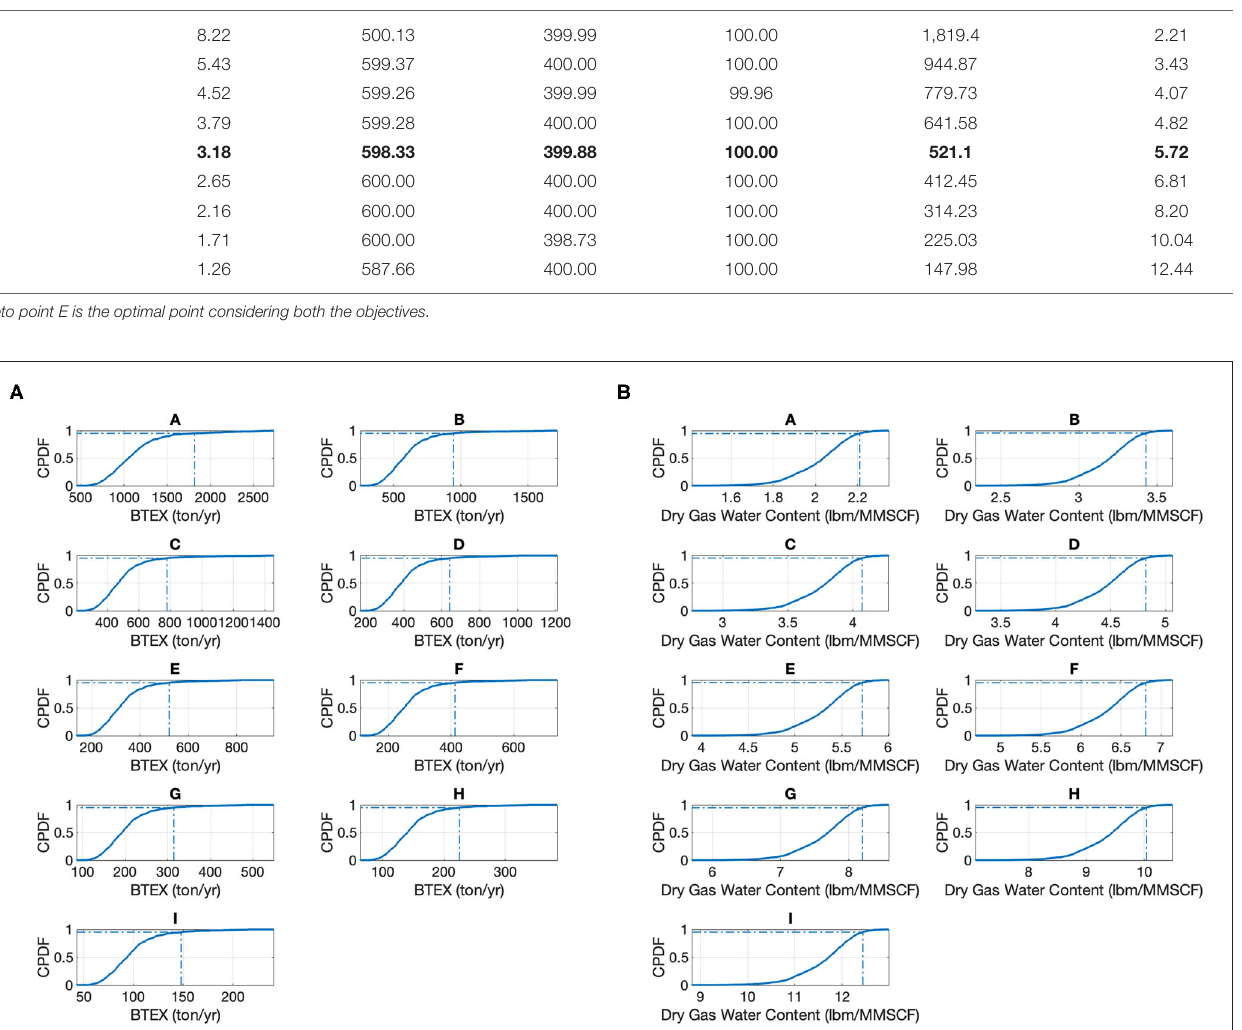
FIGURE 7 | (A) Probability distribution of BTEX emission from uncertain NG process feed compositions generated with 500 sample points at the nine Pareto optimal points as obtained from stochastic solution (RBRMOO). The reliability of the system when BTEX emission is less than the amount as given in Table 3 is 0.95 % ; (B) Probability distribution of dry gas water from uncertain NG process feed compositions generated with 500 sample points at the nine Pareto optimal points as obtained from stochastic solution (RBRMOO). The reliability of the system when DryG is less than the amount as given in Table 3 is 0.95 %